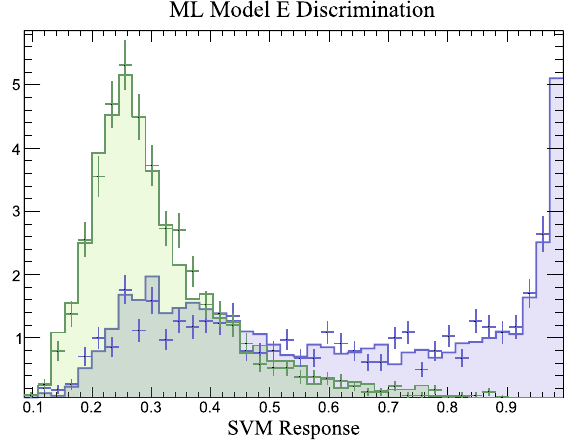
Fig. 56 (Figure 8 from [228]) On the left, discrimination of signal (blue) from bb background (green) using a support vector machine. The flat bars (points) correspond to the training (test) set. On the right, Receiver Operation Characteristic ROC for four different lifetimes of